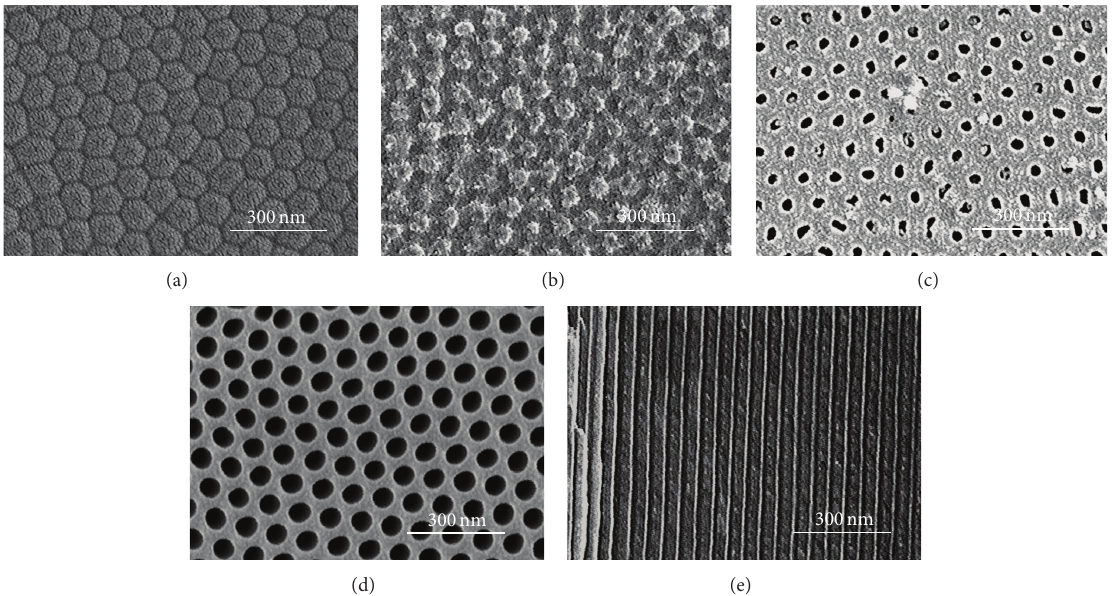
Figure 1: 3 wt%-KOH was used to remove the barrier layer as a function of etched time: (a) 0min, (b) 3 min, (c) 6 min, and (d) 7.5 min, respectively, and (e) side view of